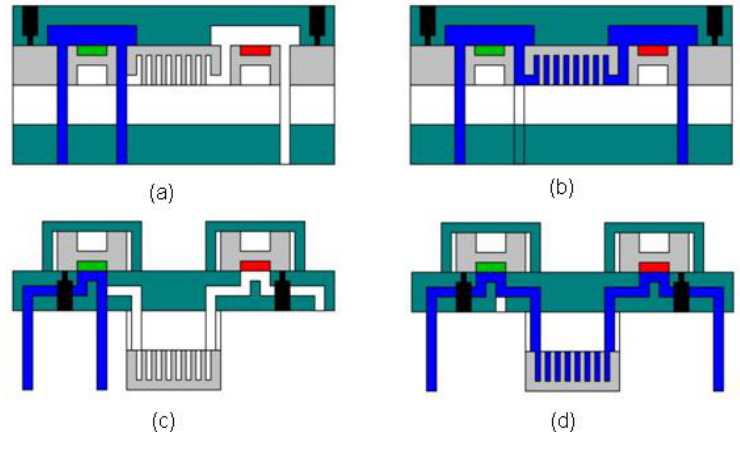
Figure 6. Side view schematics of monolithically-integrated ( a ) & ( b ) and hybrid integrated ( c ) and ( d ) assembling and packaging of μGC systems. Images (a) and (c) show the systems in sample mode (with gas flow (colored blue) past the PCs (“green” adsorbent) and exiting into the waste stream), while (b) and (d) show analysis modes with flow through the μGC column (illustrated with “fin-like” structure) and past the sensors (“red” adsorbent).